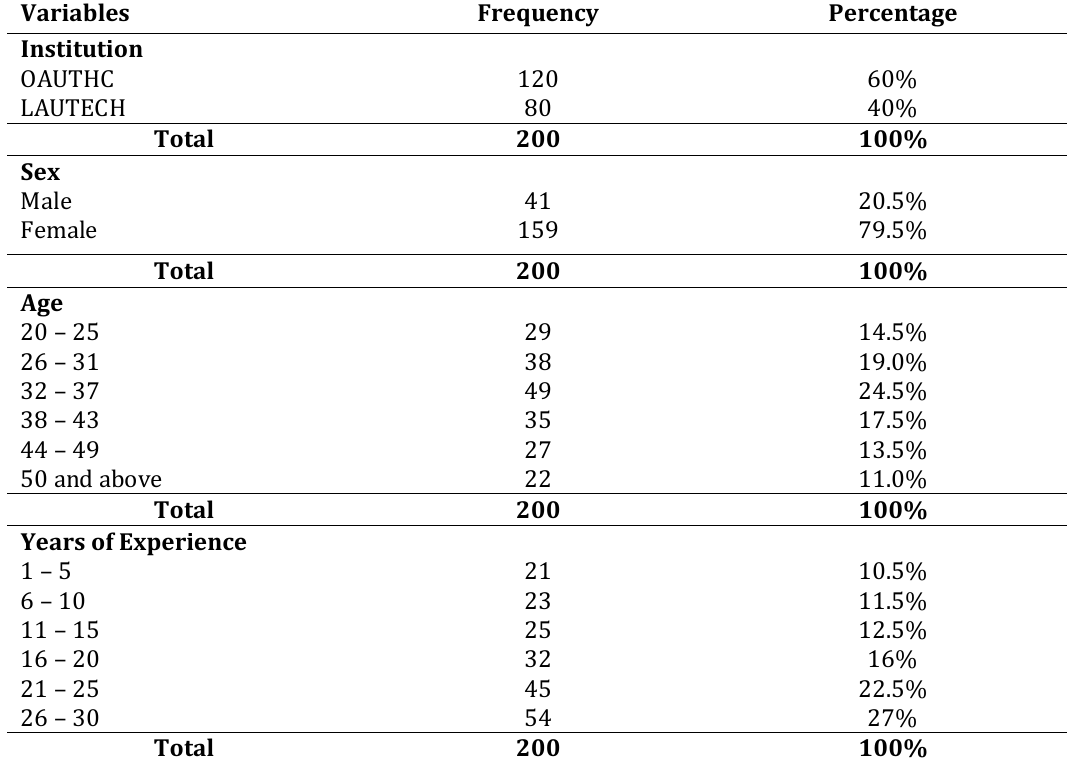
Demographic variables of respondents